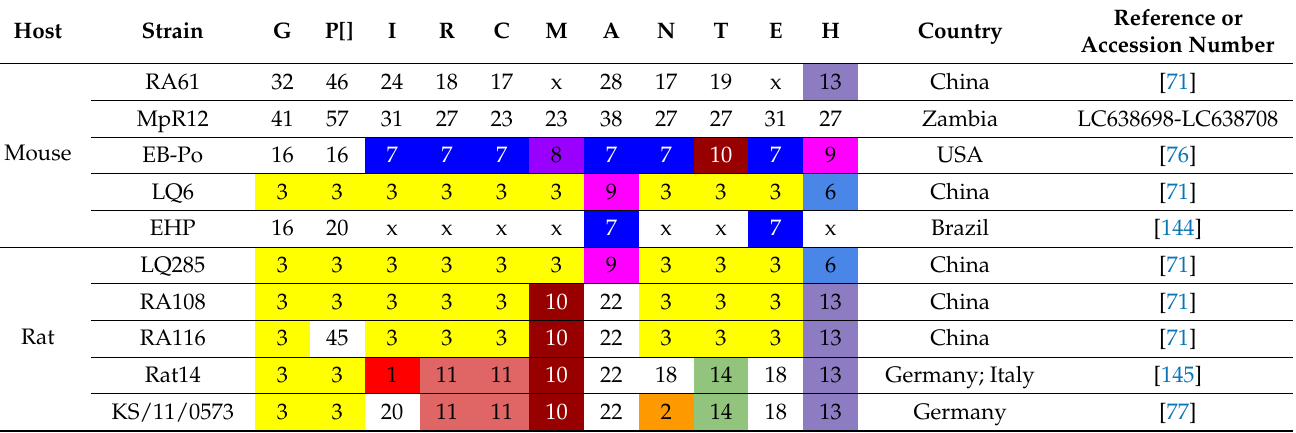
Table A10. Murine constellations.